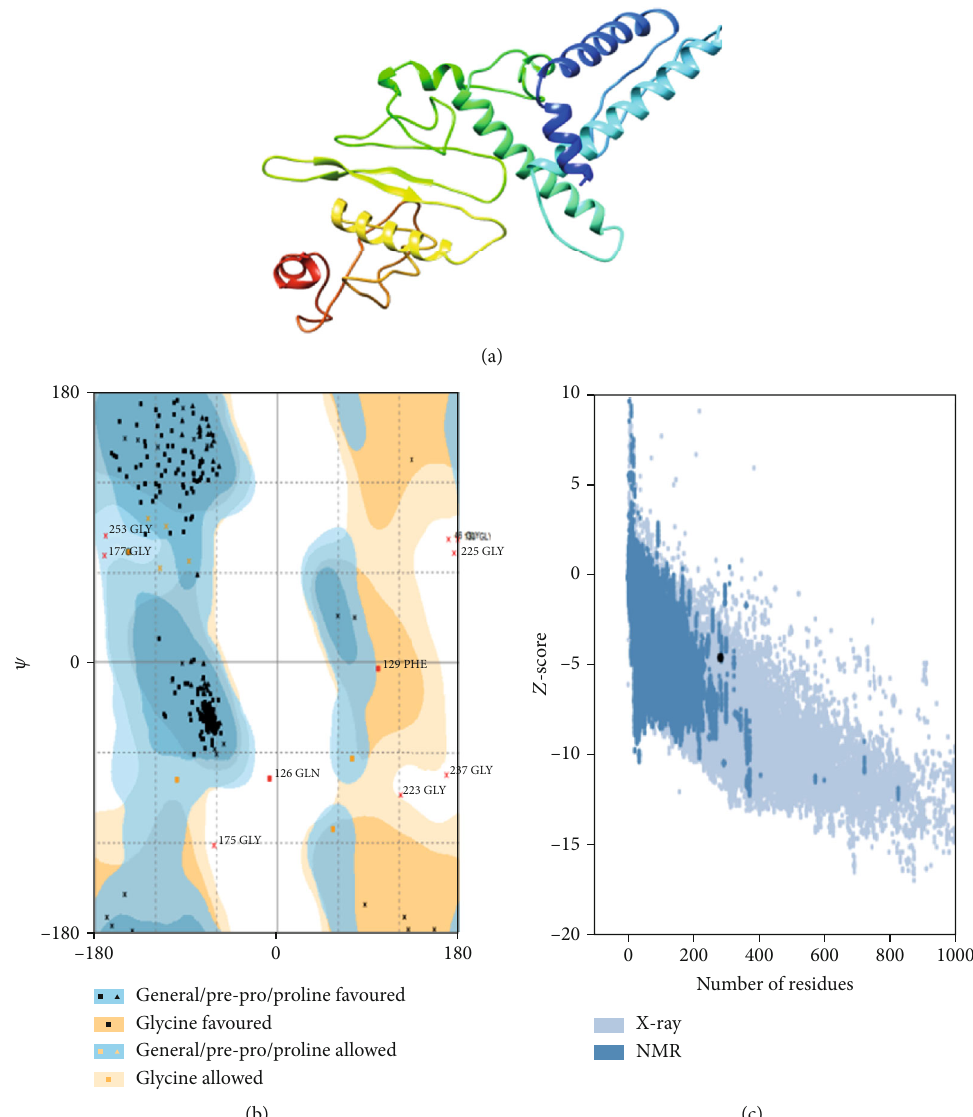
Figure 2: Structure-based assessments of the vaccine construct obtained after molecular modelling and re fi nements. (a) The three- dimensional re fi ned model of the vaccine is visualized. (b) Ramachandran plot analysis of the structural model suggests high quality. (c) The ProSA Z -score of the best model is found to be good, i.e., -4.48, thus indicating near-native con fi guration. Table 2: Ellipro results showing discontinuous B-cell epitopes. Sr.